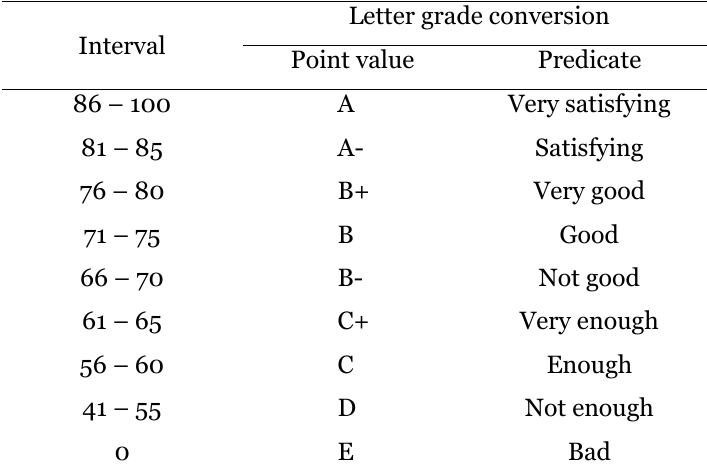
Grading Scale of UNY Academic